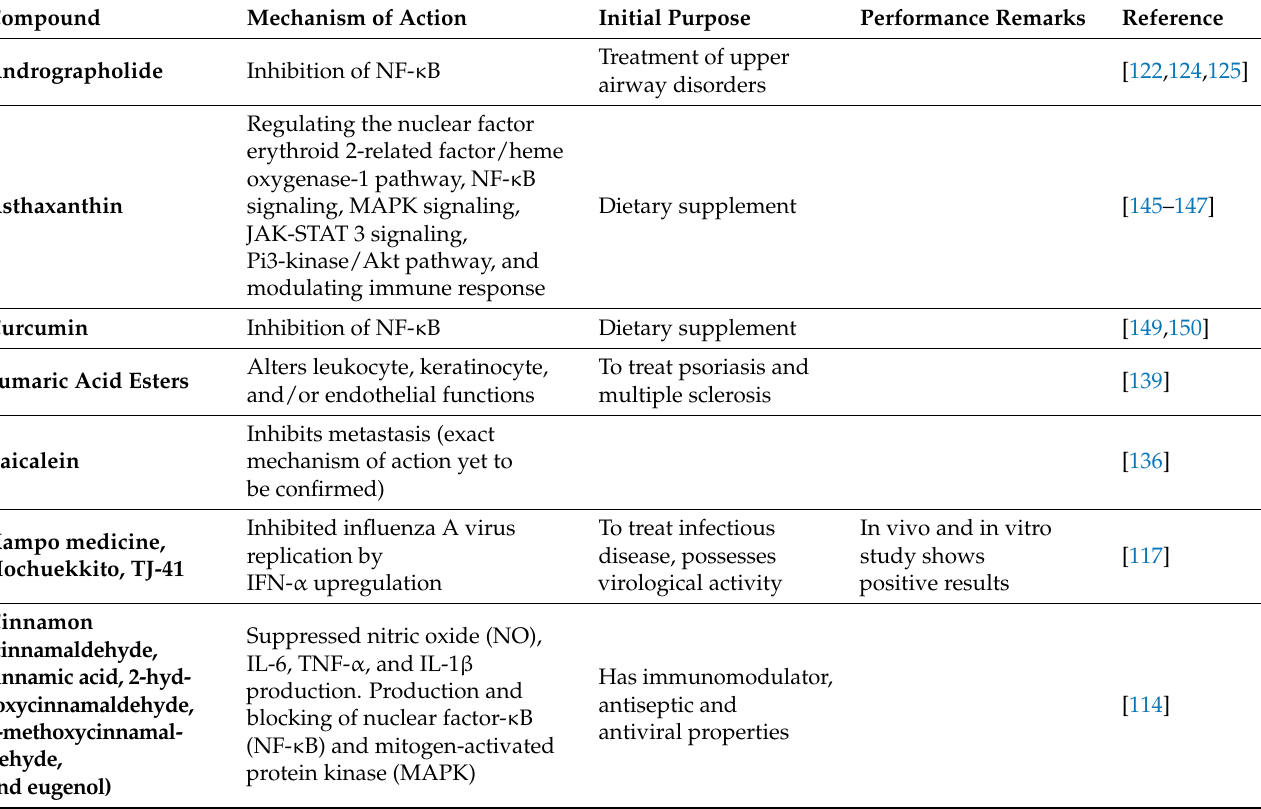
Table 4. List of natural compounds to target inflammation in